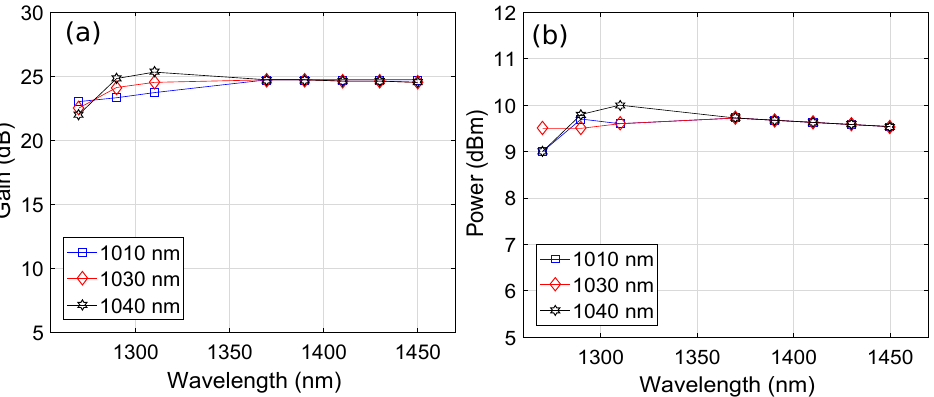
Figure 3. Wavelength versus ( a ) gain plots as a function of the pump wavelength and ( b ) output power plots as a function of the pump wavelength.